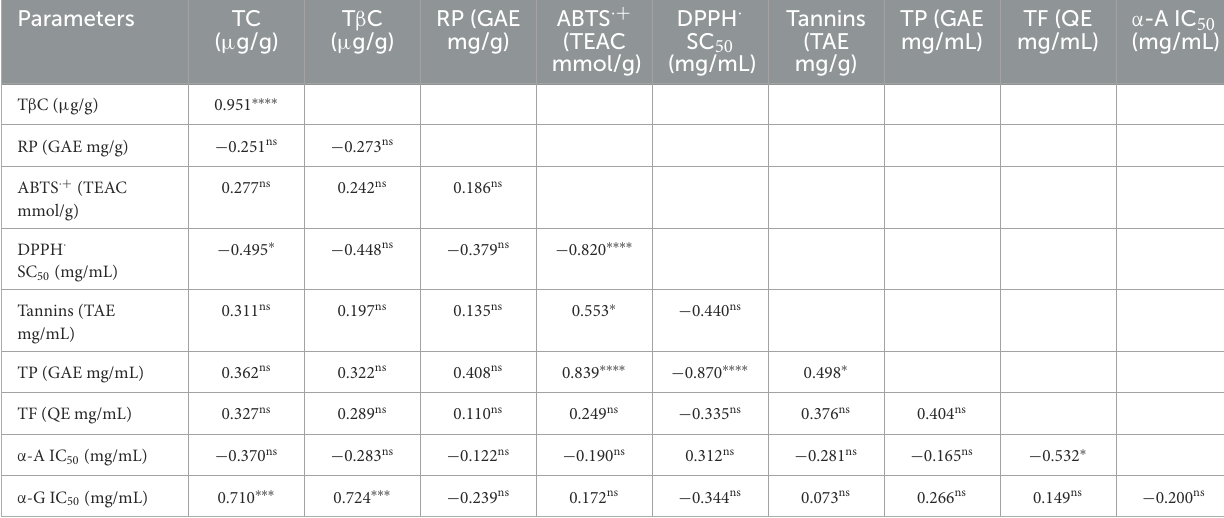
TABLE 6 Correlations among the bioactive constituents, antioxidant and starch-hydrolysing enzymes inhibitory activities of flours of 18 elite yellow-fleshed cassava genotypes. Parameters TC ( µ